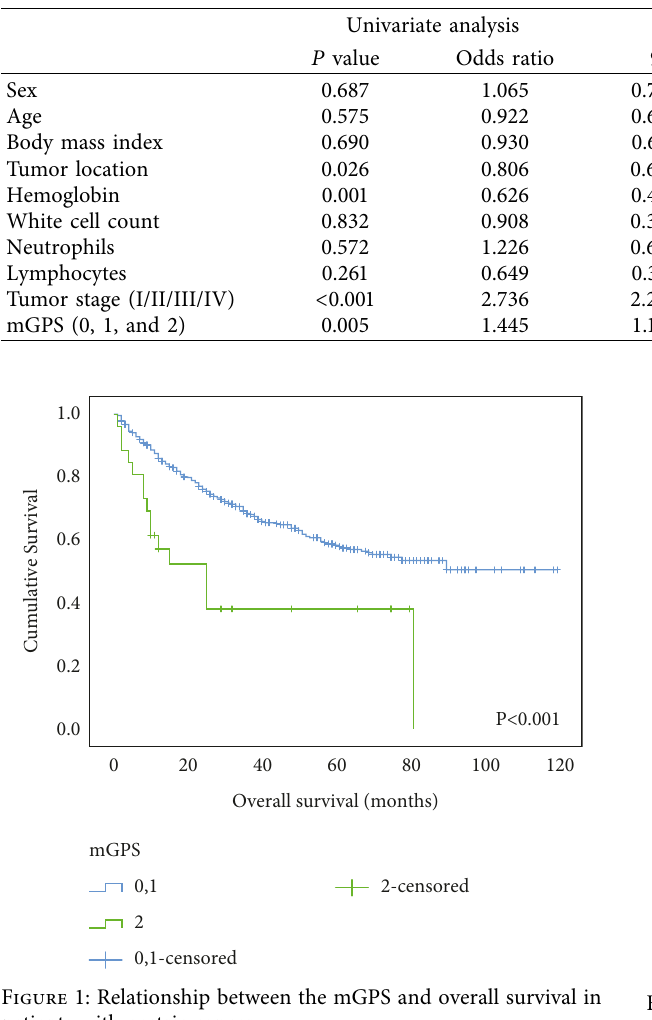
Table 3: Univariate and multivariate analyses of overall survival.